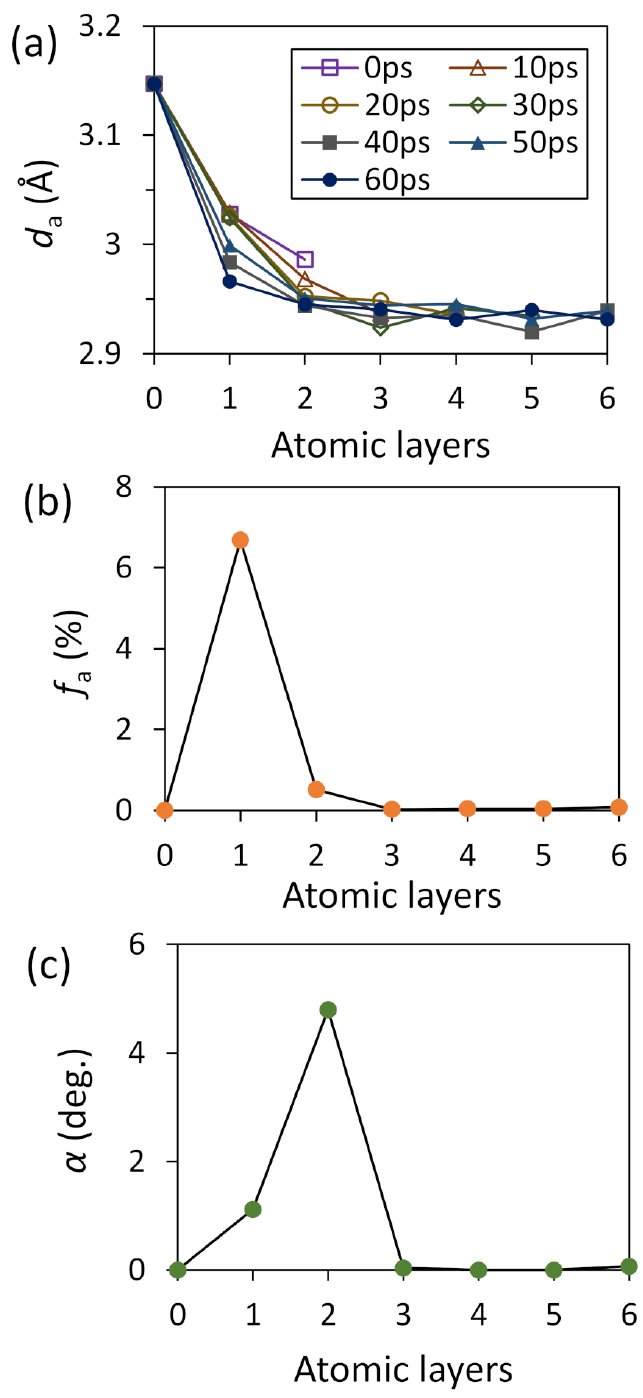
Figure 8. Mechanisms of heterogeneous nucleation demonstrated by a system with − 8% misfit. ( a ) Average in-plane atomic spacing ( d a ) in the individual layer as a function of time showing the structural transition from the substrate to the new solid within the first 3 atomic layers; ( b ) lattice misfit accommodated in each atomic layer showing that the misfit between the substrate and the solid is mainly accommodated by the 1st layer (L1); and ( c ) the twist angle of each layer relative to the previous layer showing that L2 twists an angle ( α = 5 ◦ ) relative to